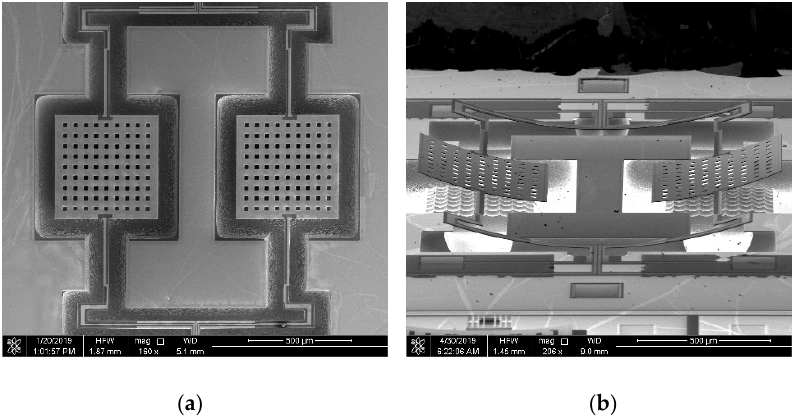
Figure 6. The micrographs of the AlN MEMS accelerometer. ( a ) Top view; ( b ) side view .